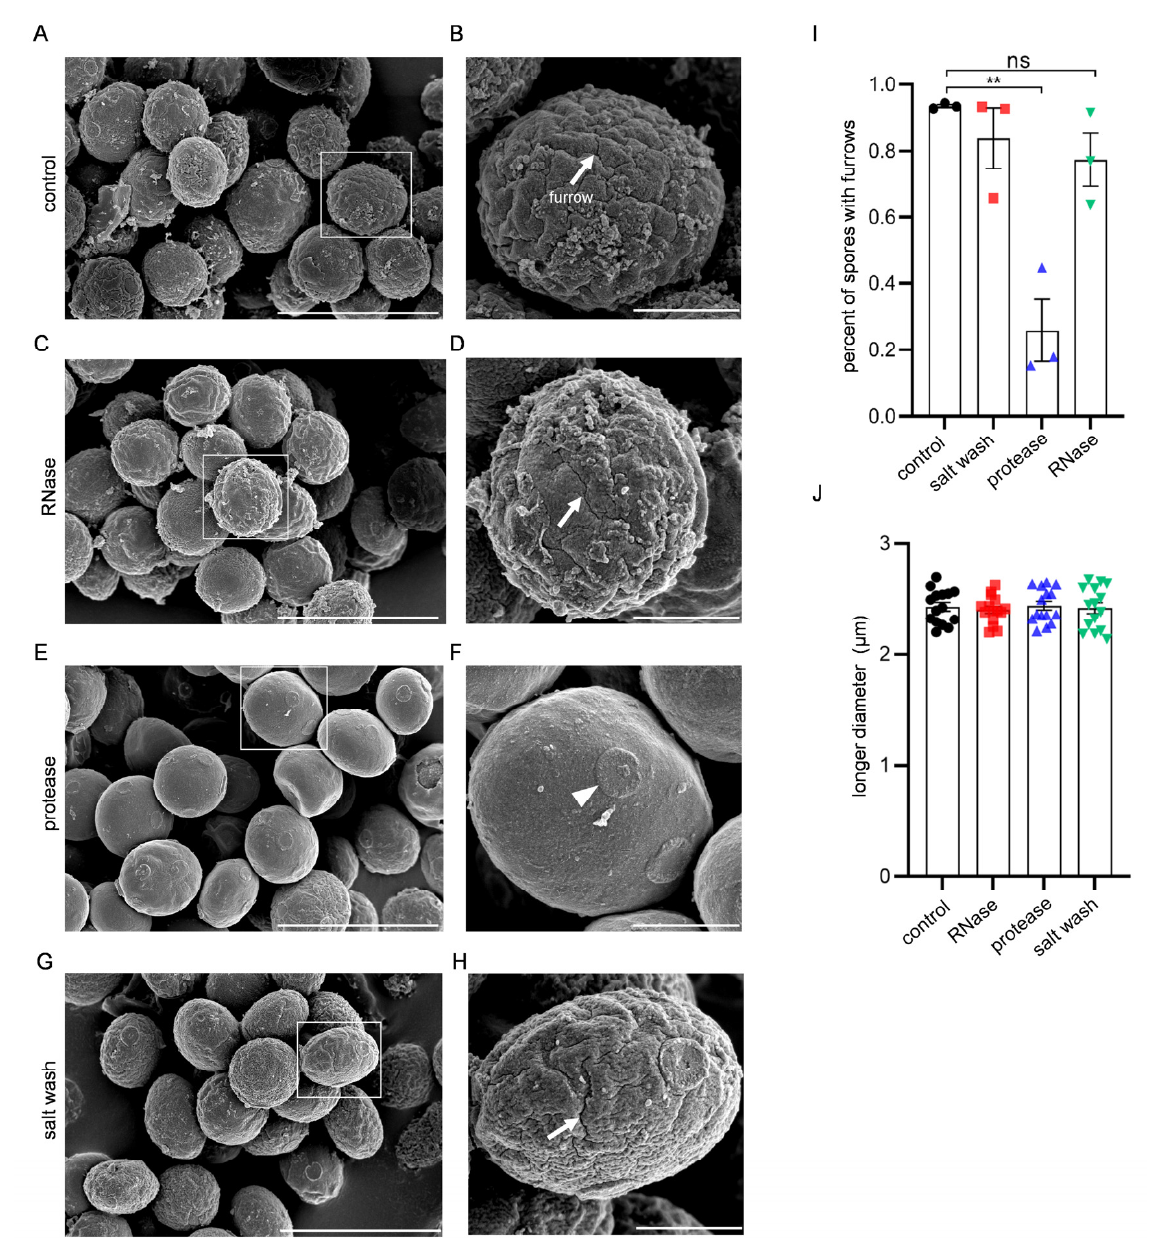
Figure 3. FESEM analysis of the surface morphology of spores. ( A ) Untreated control. ( C , E , G ) RNase-, protease-, or salt washed spores, respectively. ( B , D , F , H ) Close-up of the boxed areas in ( A , C , E , G ), respectively. ( A , C , E , G ) Scale bar, 5 μ m. ( B , D , F , H ) Scale bar, 1 μ m. Arrows in ( B , D , H ) indicate furrows. The arrowhead in ( F ) indicates a probable interspore bridge scar. ( I ) Quantification of spores with furrows. ( J ) Analysis of the longer diameters of spores. Data are presented as the mean ± SEM. Statistical significance was determined by two-tailed unpaired Student’s t -tests. n = 3 ( I ), n = 15 ( J ); **, p < 0.01; ns, not significant ( p ≥ 0.05).